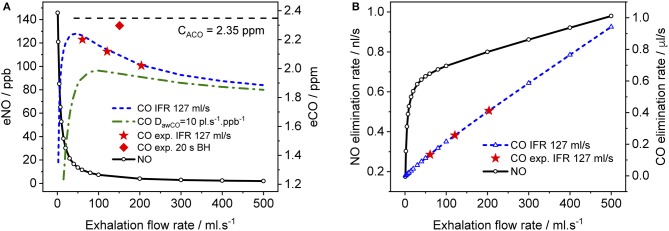
Simulated end-tidal concentrations (A) and elimination rates (B) as a function of EFR for CO (dashed lines) and NO (solid lines). The average TMAD parameters from Figures 4A–C (i.e., 220 pl/s, 1.6 pl.s−1.ppb−1, 1.82E+7 pl/s, and 7767 pl.s−1.ppb−1 for JawCO, DawCO, JACO, and DACO, respectively) are used for CO, and those from Shin and George (2002) for NO. IFR was set to 127 ml/s. Model-predicted alveolar CO concentrations (CACO) are indicated by a dashed line in (A). Experimental end-tidal values (Figure 4) for the three EFRs (star markers) and breath-holding (diamond marker) are shown for comparison.